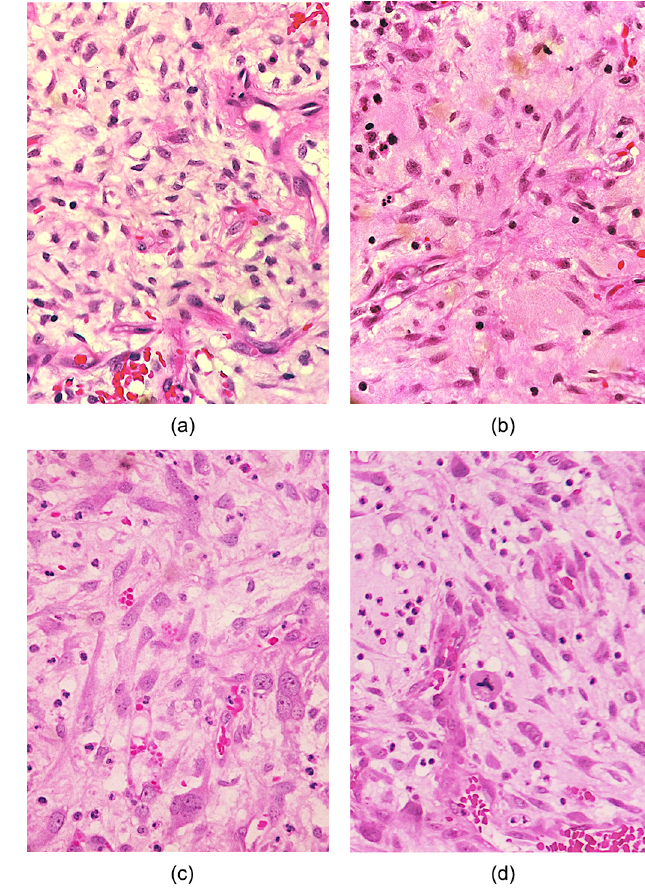
Fig. 4. Case 2. Histopathological examination of the haematoxylin- eosin stained specimen. Tapered myo fi broblast like cells with eosinophilic cytoplasm, wavy nuclei, fi ne to course chromatin (a); More hyalinised less cellular areas observed (b); pleomorphic tumour cells appear larger with multiple nuclei (c); Aberrant mitotic fi gures noted (d) (a – d, 400 (cid:1)